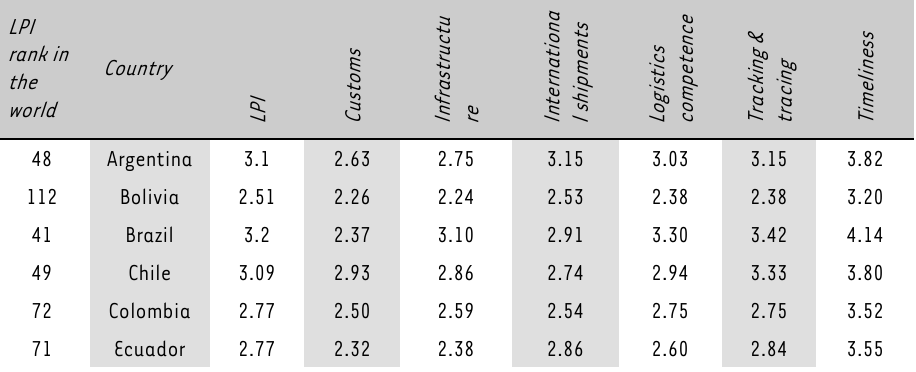
TABLE 5: Logistics Performance Index (LPI) scores for South American